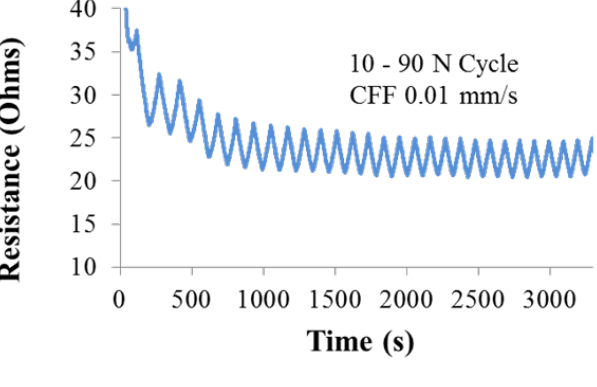
Figure 4. Resistance vs. time cyclic behavior. Cycles performed between 10 and 90 N loads using Plexiglas fixture illustrate that after some initial the conditioning cycles the Carbon Fiber Foam electrical behavior